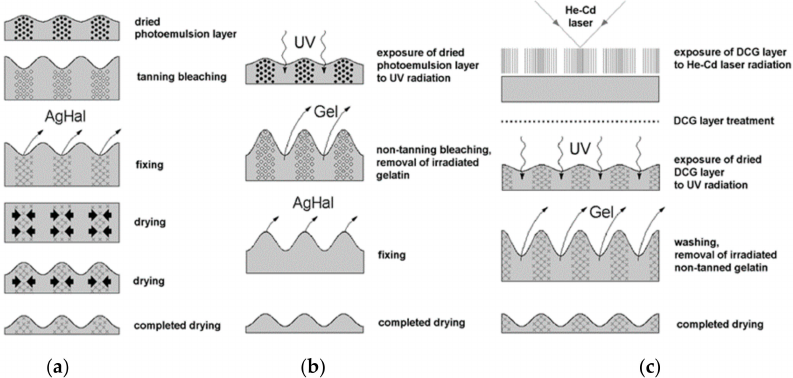
Figure 2. Creation of surface relief ( a ) during selective tanning and by destructive effect of UV radiation ( b ) on silver-halide photoemulsions and ( c ) on layers of